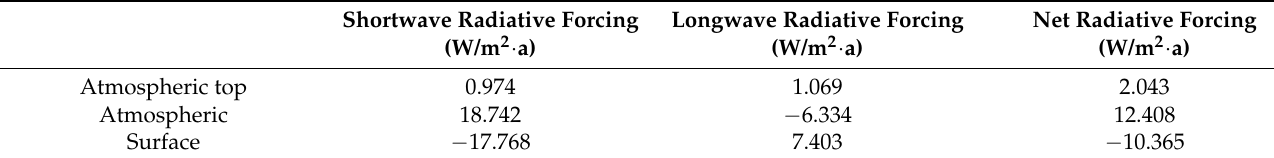
Table A1. Average dust aerosol radiative forcing in spring.